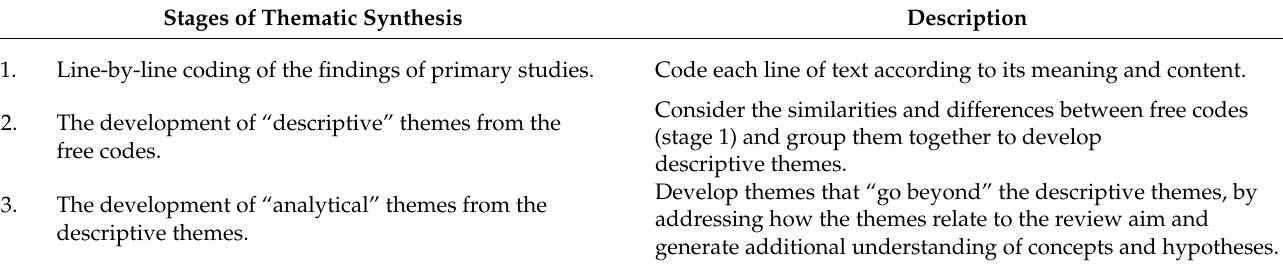
Table 1. Stages of thematic synthesis